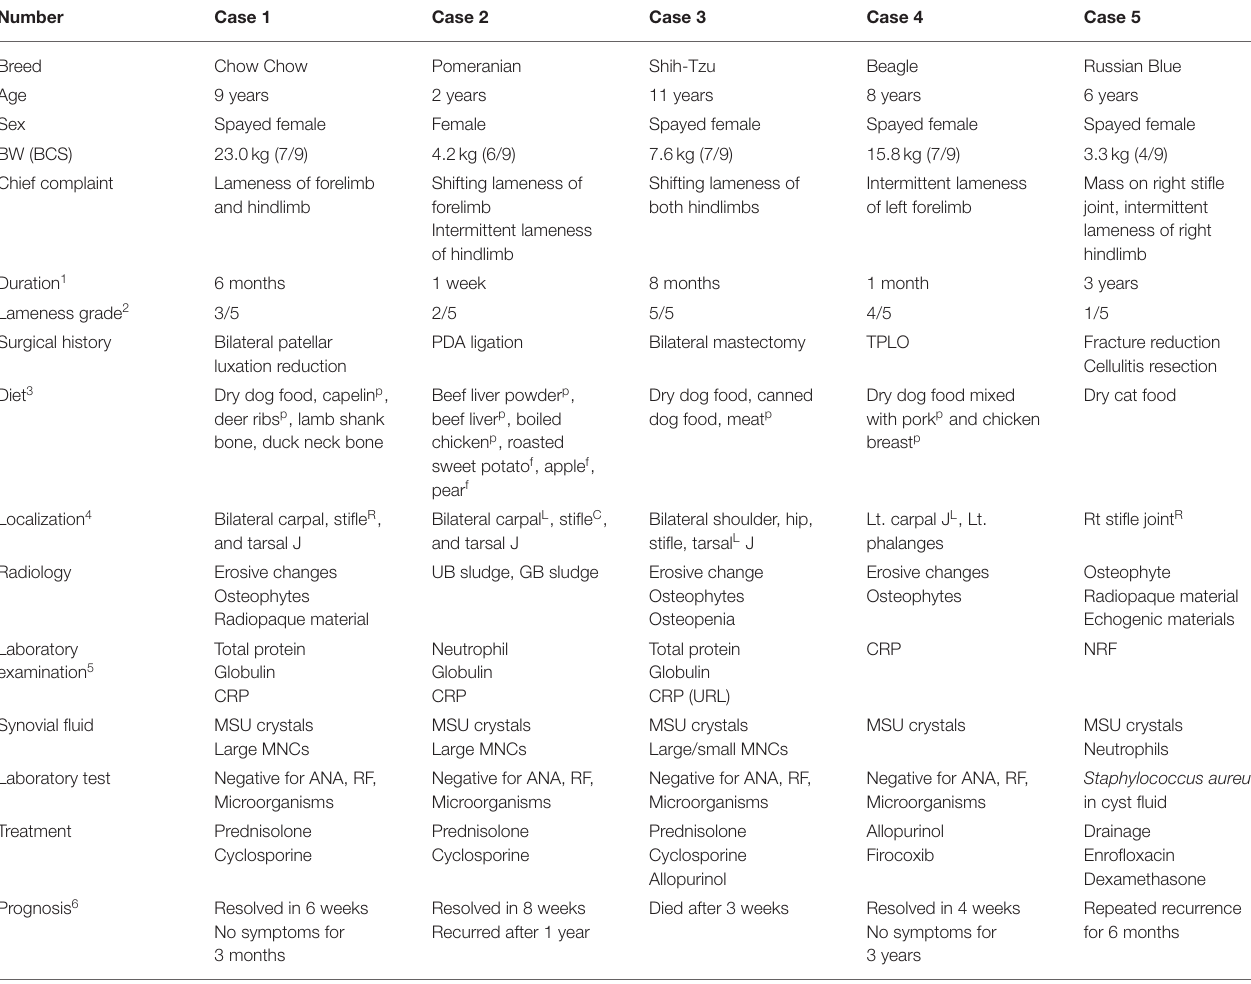
TABLE 1 | Summary of the findings in all five